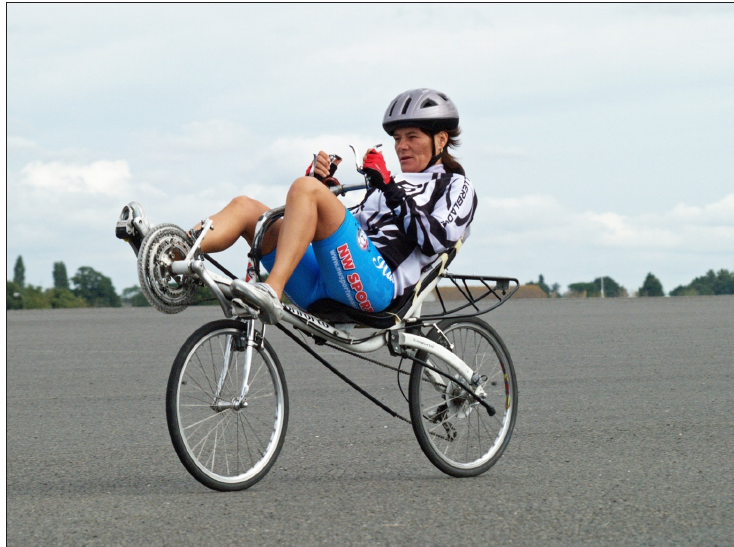
Figure 1: Typical recumbent for everyday use.